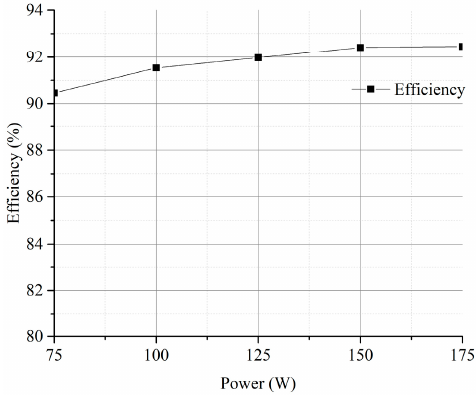
Figure 12. AC–DC DAB efficiency versus output power. Figure 12. AC-DC DAB efficiency versus output power.